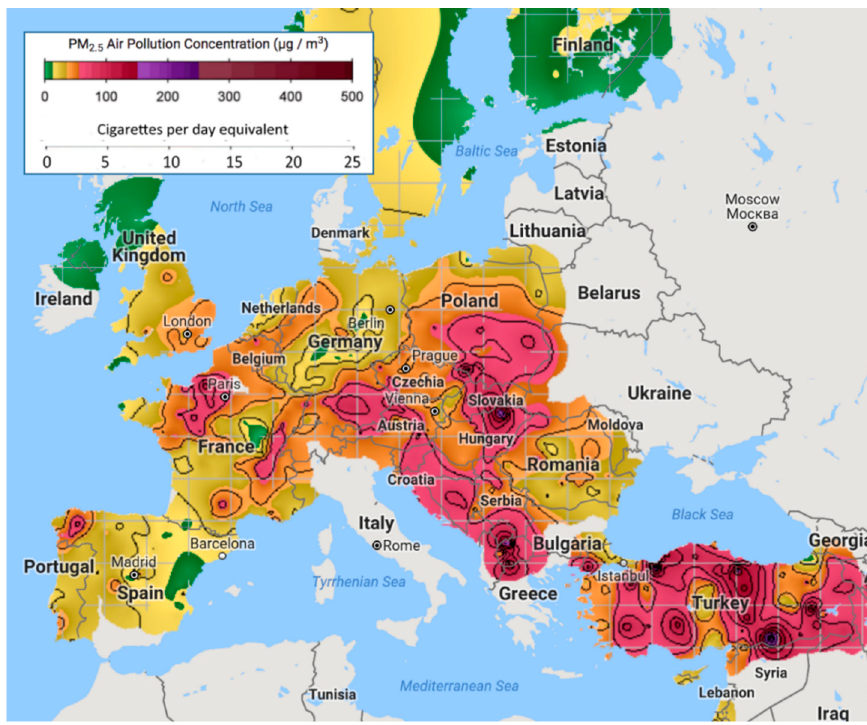
Figure 3. European PM2.5 levels. From [17].